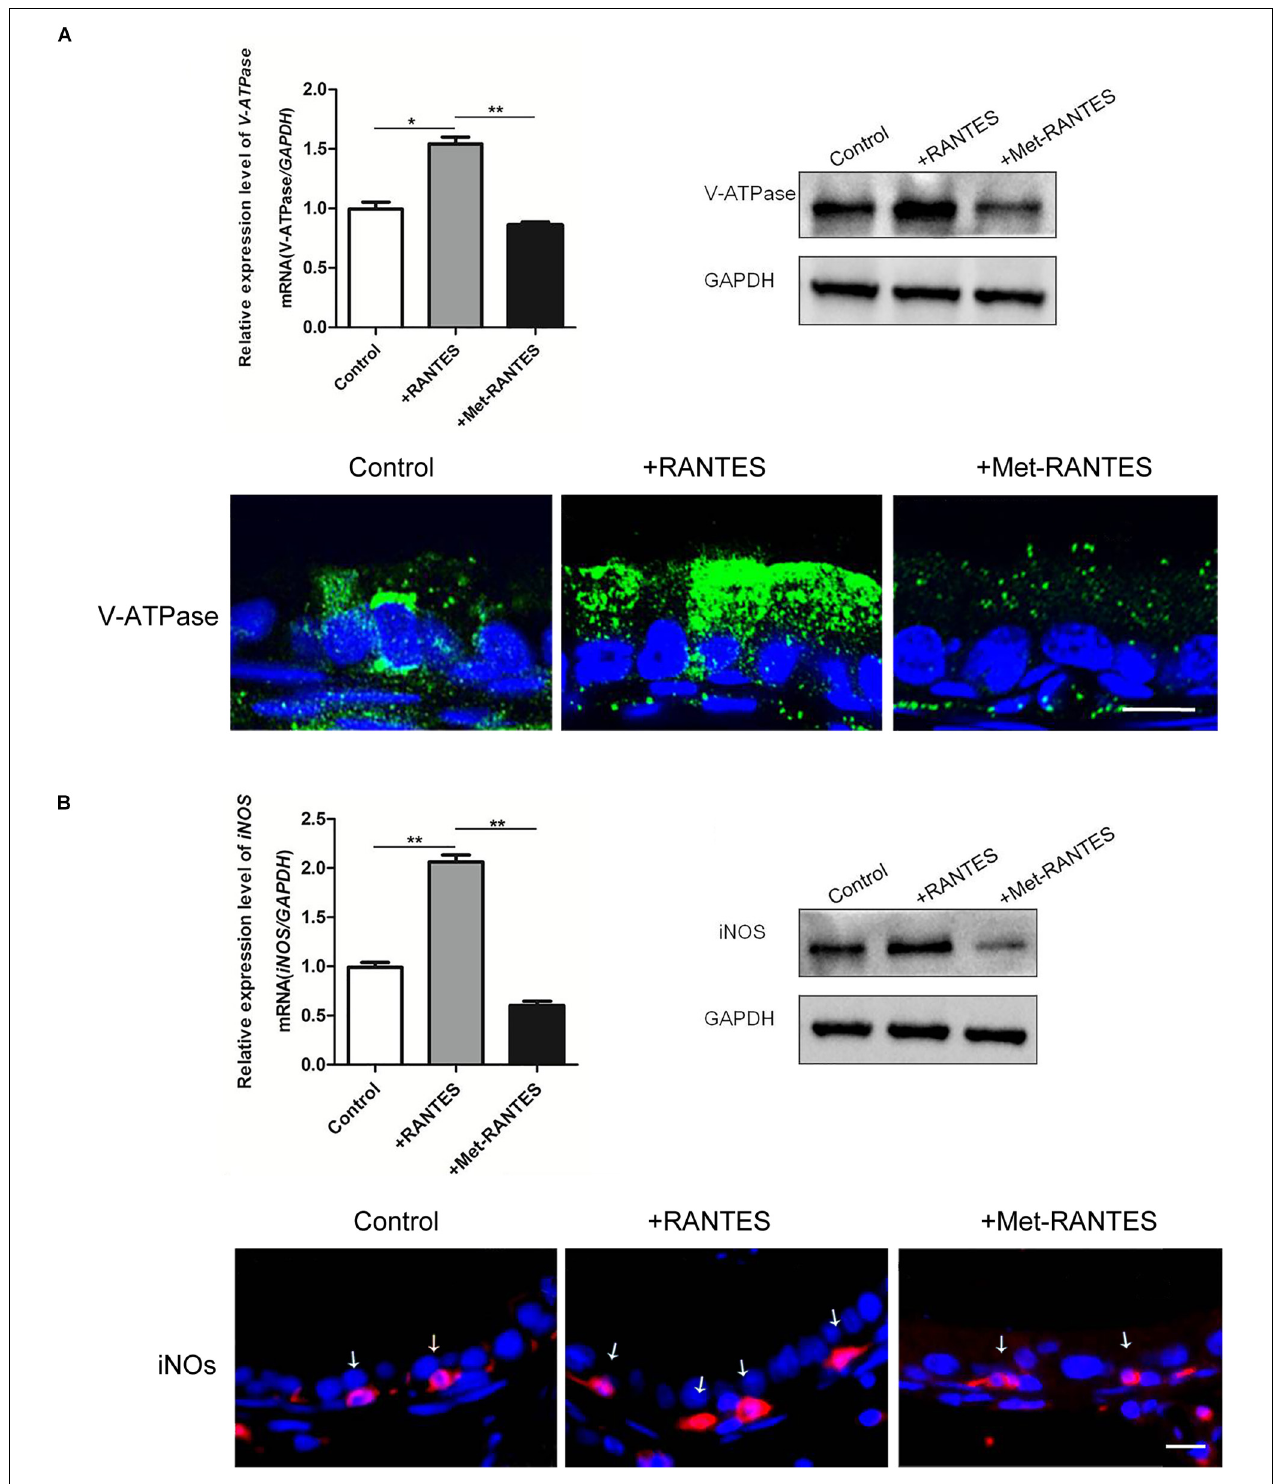
FIGURE 3 | Effects of RANTES and Met-RANTES on V-ATPase and iNOS in perfusion model. Rat cauda epididymis were perfused luminally in vivo with recombinant RANTES and Met-RANTES. Real-time PCR and WB analysis of the mRNA and protein levels of V-ATPase (A) and iNOS (B) were up-regulated by the addition of RANTES compared to the control group (pH of 6.8), but decreased with the antagonist Met-RANTES replenishment. Immunofluorescence staining showed a notable accumulation of V-ATPase in the apical membrane of clear cells (A) and a strong signal of iNOS (white arrows) in the epididymis (B) by the addition of RANTES, whereas it decreased with Met-RANTES replenishment. ** P < 0.01, * P < 0.05, N = 5–6, Bar = 20 µ m.